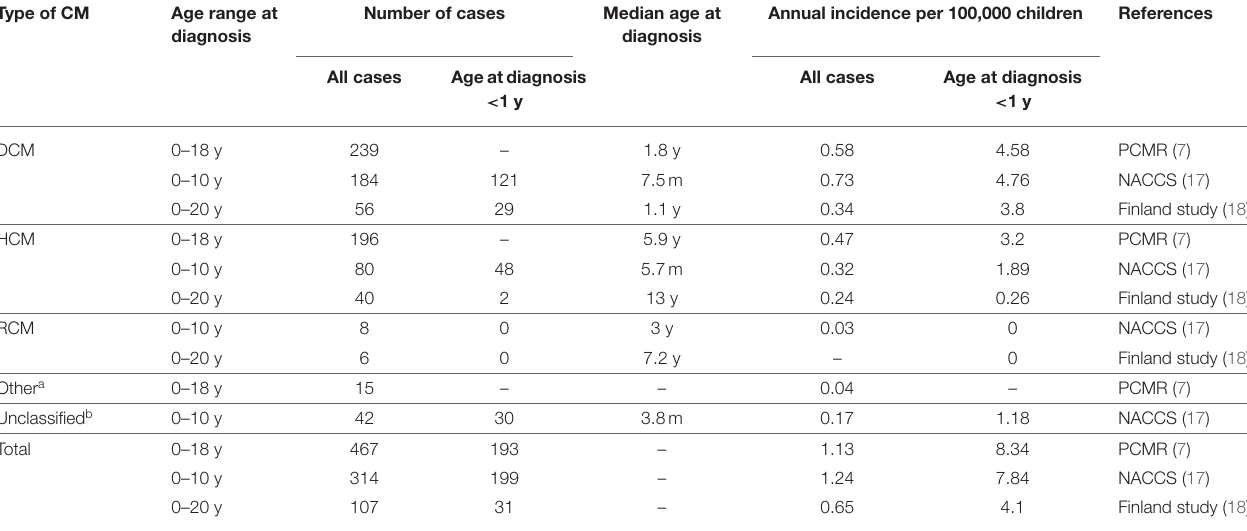
TABLE 1 | Annual incidence and median age at diagnosis for each type of cardiomyopathy (CM). Type of